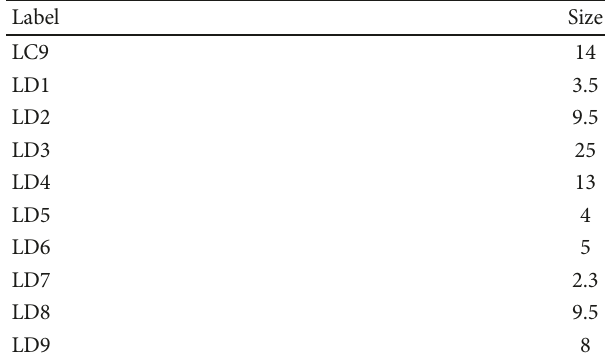
Figure 2, that is, antenna unit S -parameter in Figure 2(a) and radiation pattern of the antenna unit in Figure 2(b).